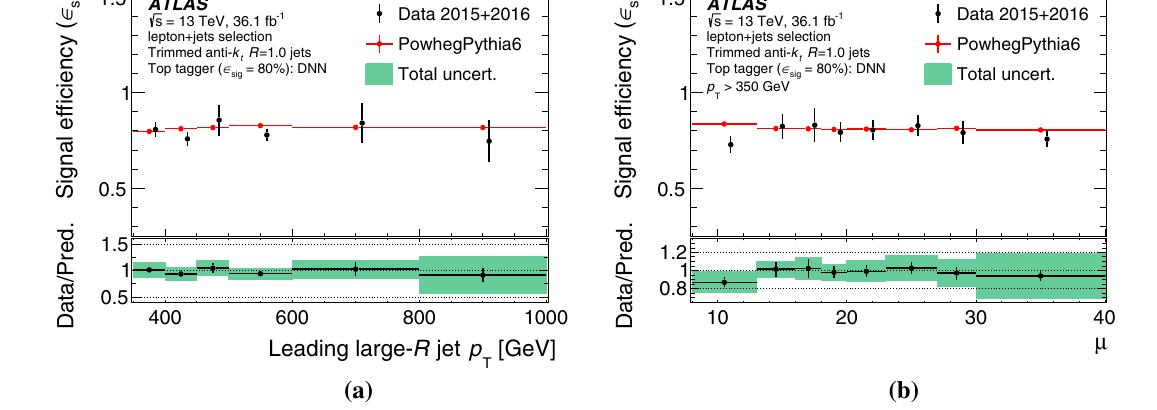
in data to that estimated in Monte Carlo is shown with statistical uncer- tainties as error bars on the data points and the sum in quadrature of statistical and systematic uncertainties as a shaded band. When consid- ering experimental uncertainties arising from the large- R jet, only those coming from the jet energy scale and resolution are